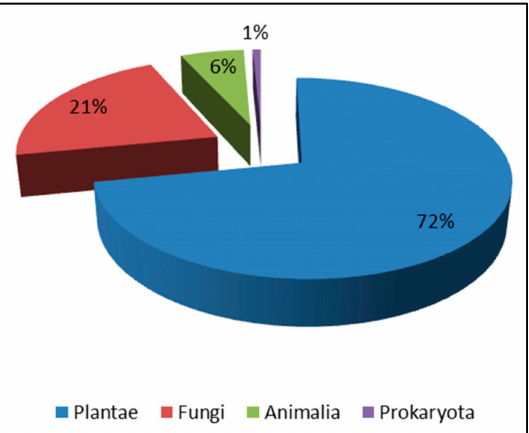
Figure 36. Distributions of enantiomers in kingdoms Plantae, Fungi, Animalia and